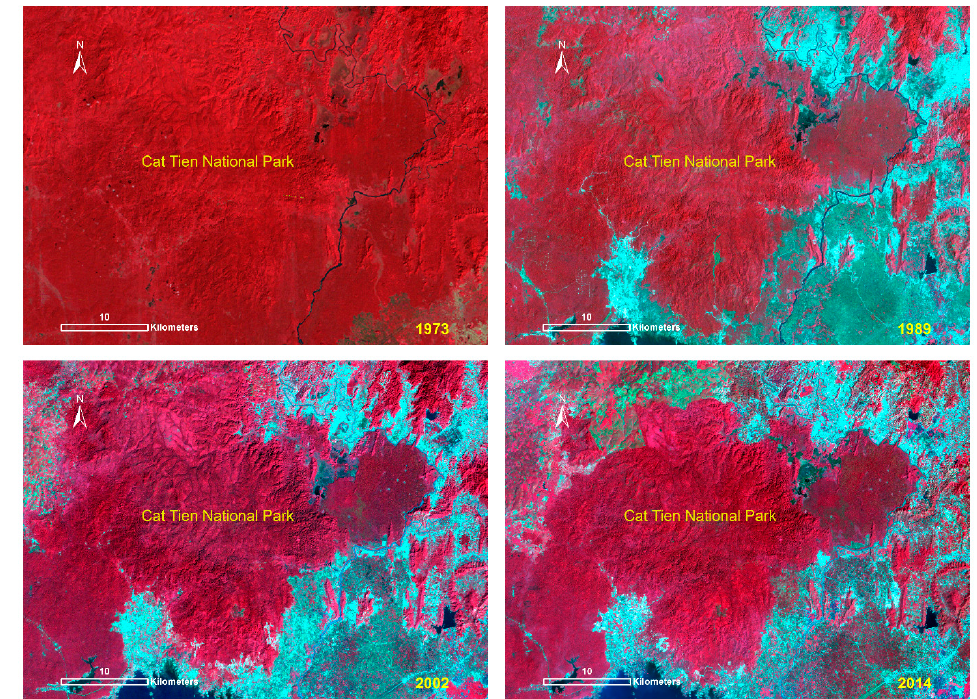
Figure 6. Landsat false color composites from different epochs. All images were produced using near-infrared, red, and green bands in the order of red, green, and blue. The 1973 image is from Landsat 1 Multispectral Scanner System (bands 4-2-1), 1989 imagery is from Landsat 5 (bands 4-3-2), 2002 imagery is from Landsat 7 (bands 4-3-2), and the 2014 image is from Landsat 8 (bands 5-4-3).